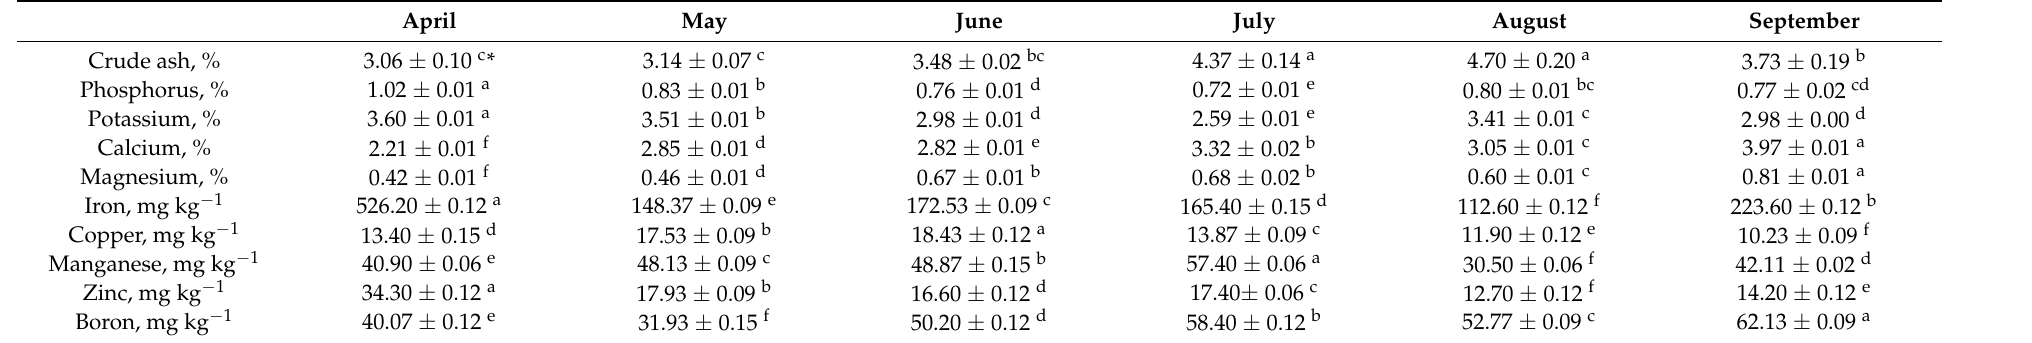
Table 2. Crude ash and mineral elements of stinging nettle ( Urtica dioica L.) leaves